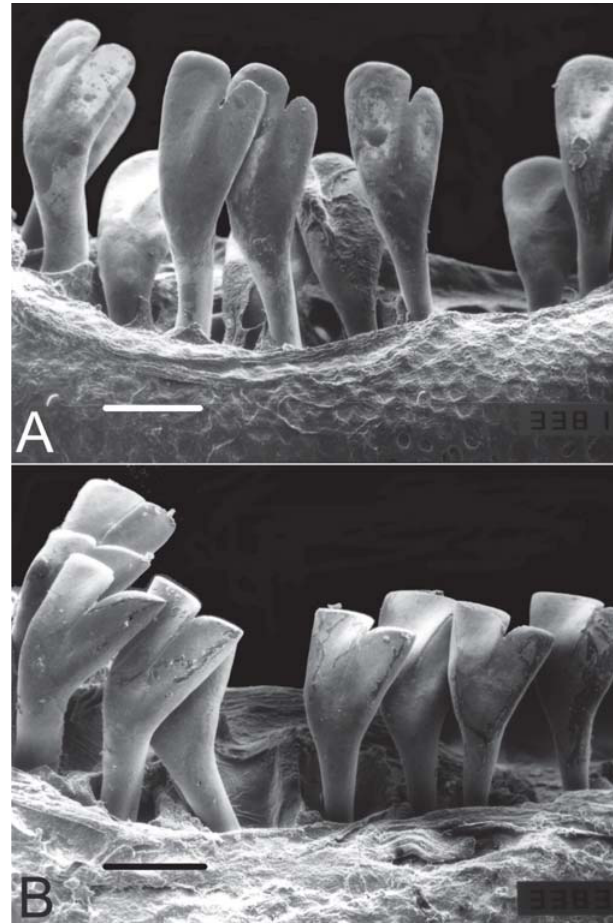
Fig. 7. Scanning electron micrographs of premaxilary teeth of Ixinandria steinbachi ¸ showing sexual dimorphism in teeth cusps. A) MCNI 419, 69.3 mm SL, male; B) MCNI 419, 71.1 mm SL, female. Scale 700